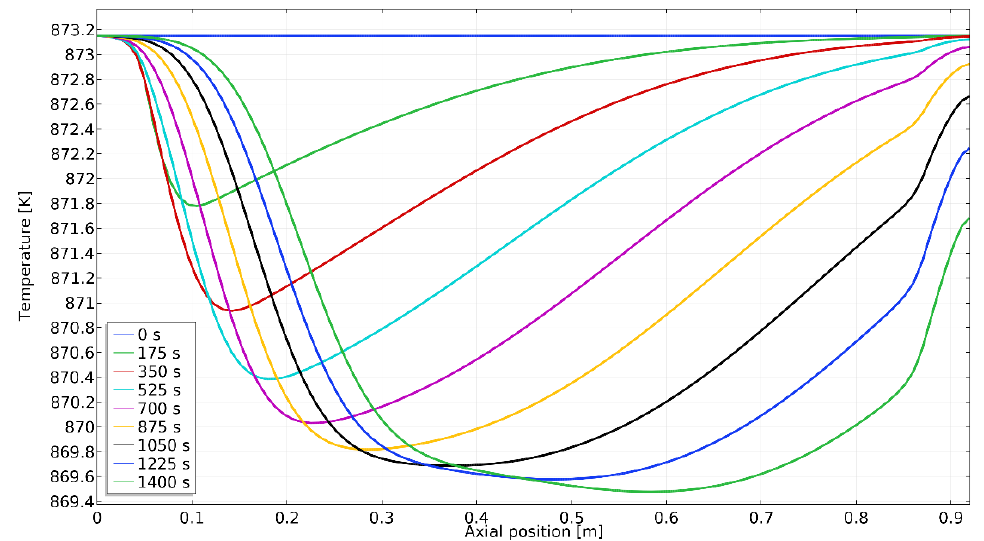
Figure 10. Model predicted axial temperature profiles during reduction with CO.